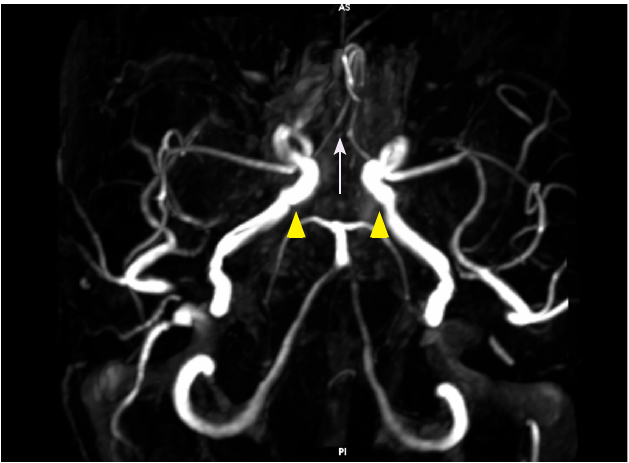
Figure 2. Absent ACOM (Arrow) and B/L PCOM (Arrowheads).